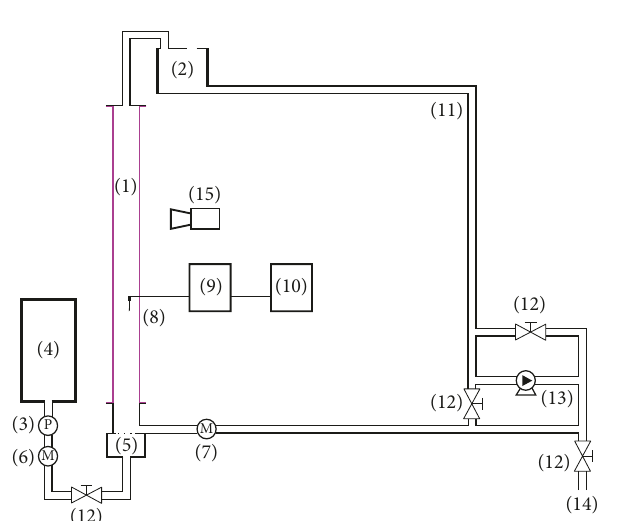
Figure 5: Air-water two-phase flow loop: (1) test section, (2) gas- liquid separation tank, (3) pressure gauge, (4) air plenum, (5) two-phase mixing device, (6) gas flowmeter, (7) electromagnetic flowmeter, (8) dual needle-contact capacitance probe, (9) data acquisition system, (10) computer, (11) single-phase water pipe, (12) valve, (13) pump, (14) water inlet, and (15) high-speed video camera.